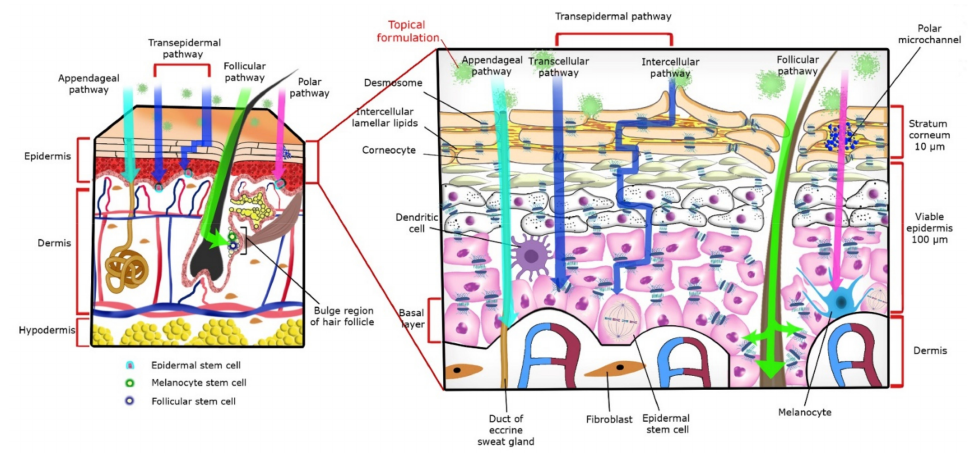
Figure 1. Pathways of penetration to the